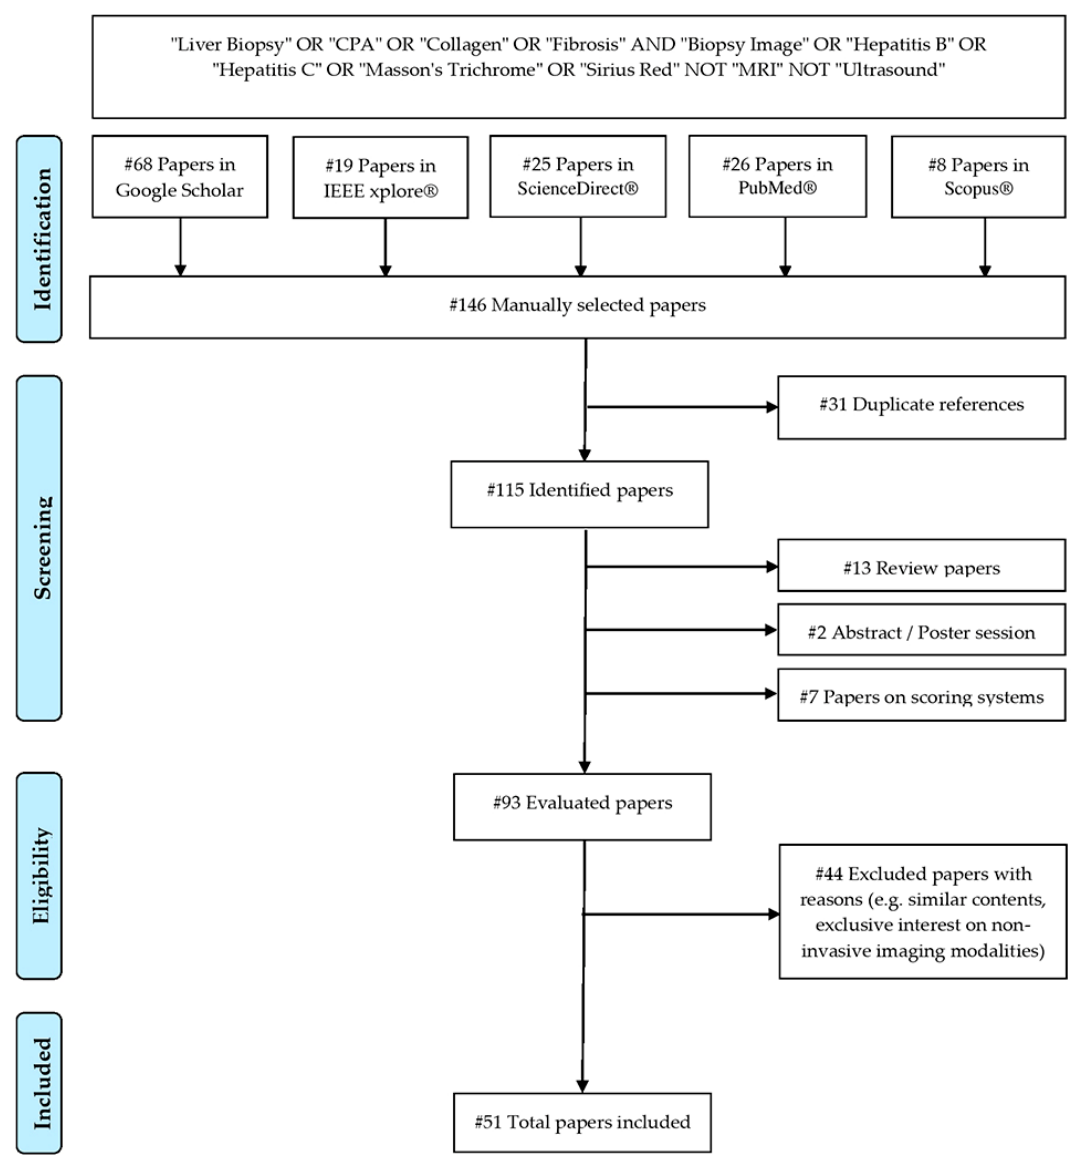
Figure 4. Paper selection flowchart according to the Preferred Reporting Items for Systematic Reviews and Meta-Analyses (PRISMA) statement.